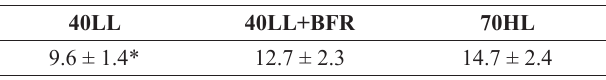
Table 5. Ratings of perceived exertion (RPE) at the constant load ses-